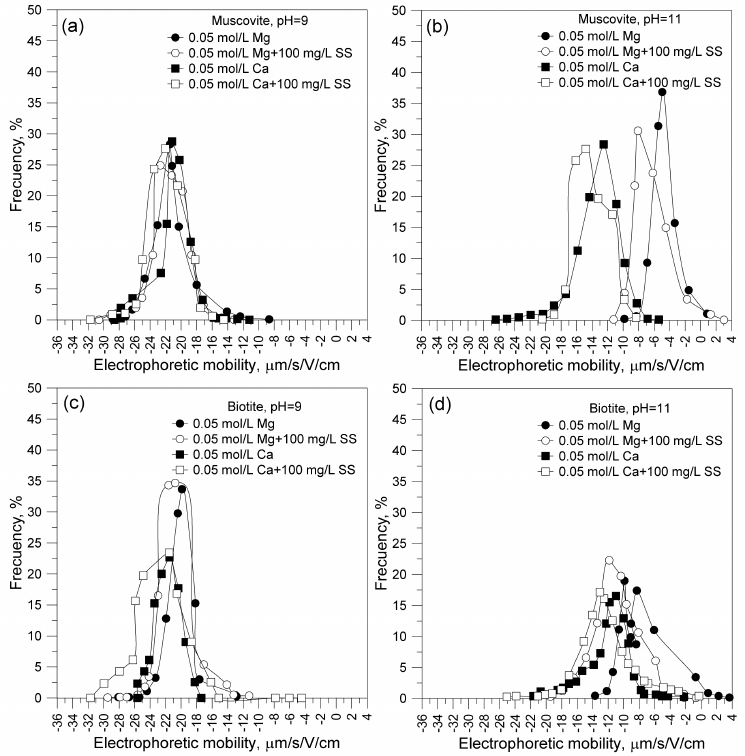
Figure 7. Electrophoretic mobility distributions of particles of biotite ( a , b ) and muscovite ( c , d ), with and without SS, in aqueous solutions of magnesium and calcium, and at pH 9 and